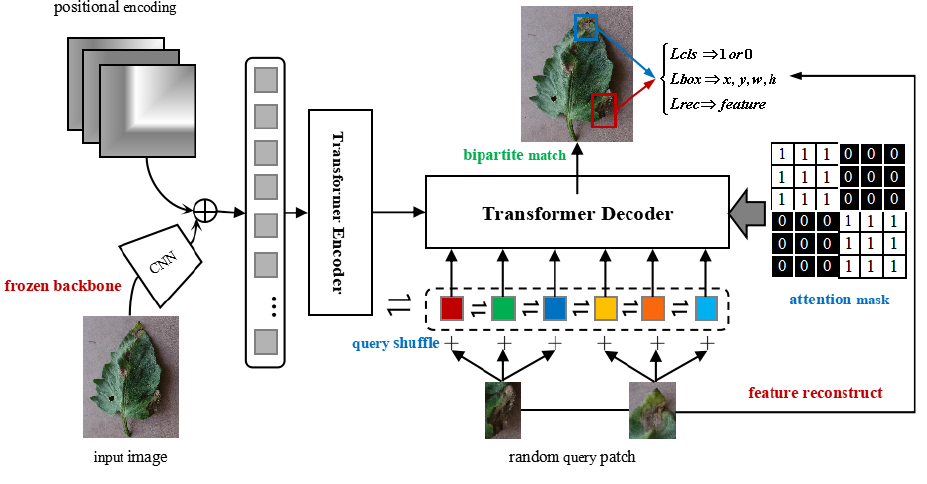
Figure 4. Unsupervised pre-training process.